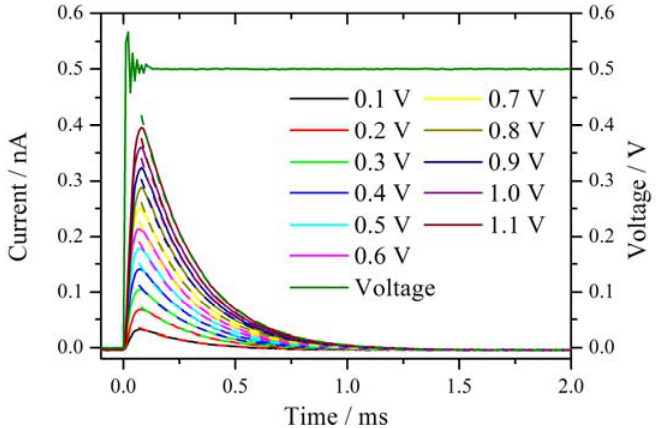
Figure 2. Current traces measured in a series by increasing the potential jump from 0 V to the corresponding value given in the diagram. The measurements were performed at the same position in a hydrogen atmosphere with 76% RH. The dashed lines represent the fitted exponential decay with a time constant of around 0.24